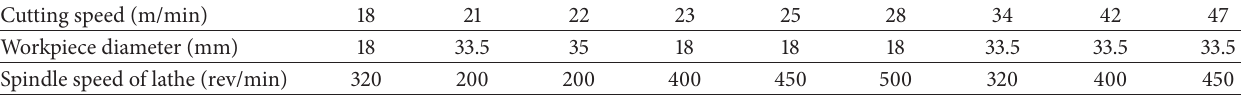
Table 2: Transforming relationship of cutting speed and workpiece diameter used in the experiment.